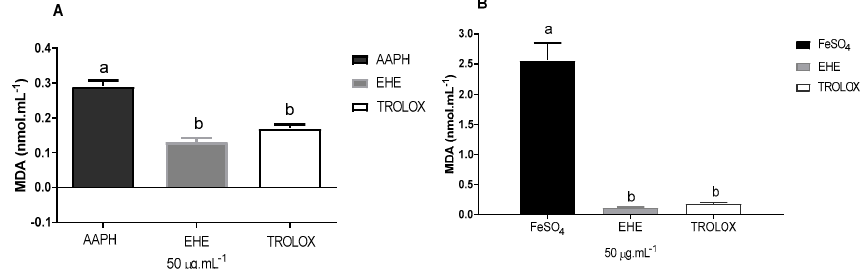
Figure 3. Effects of the hydroethanolic extract of B. virgilioides on the concentration of malondialdehyde (MDA) formed by the lipid peroxidation induced by AAPH ( A ) and FeSO 4 ( B ). Results are presented as concentration of malondialdehyde formed (nmol mL − 1 ). Values are expressed as means ± standard error of the mean. The letters “a” and “b” when repeated indicate statistical differences between the groups ( n = 3). Statistical analysis was determined by via one-way ANOVA (Bonferroni post-hoc test, p < 0.05).